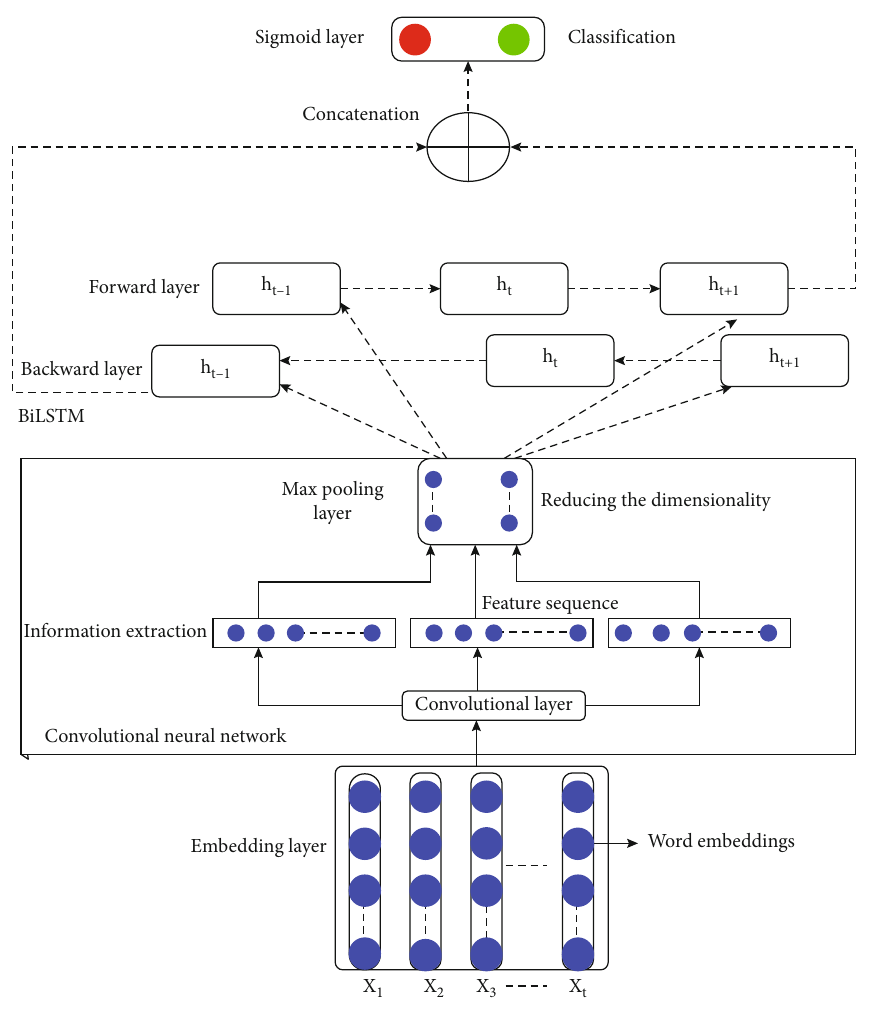
Figure 2: Structure of the CNN-BiLSTM model for troll reviewer detection using sentiment analysis.